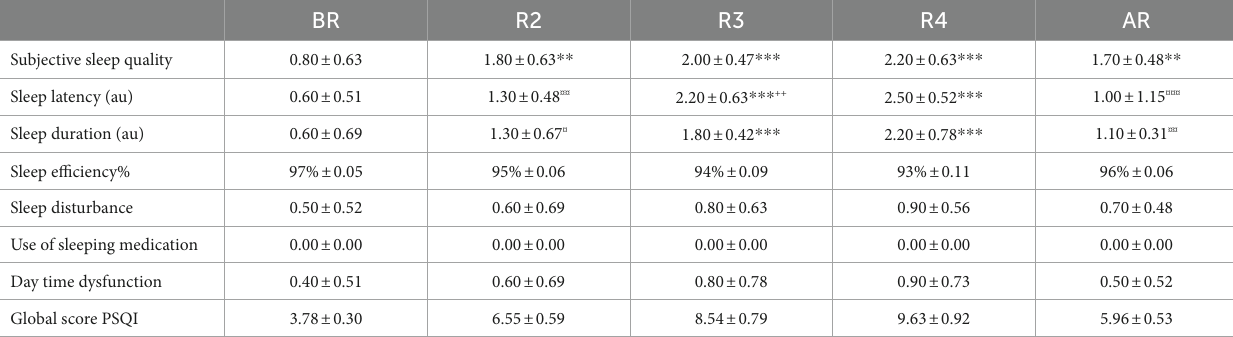
TABLE 4 PSQI questionnaire parameters (mean ± SD) recorded 1 week before Ramadan (BR), at the 2nd week of Ramadan (R2), at the 3rd week of Ramadan (R3), during the 4th week of Ramadan (R4) and 2 weeks after Ramadan (AR; n =